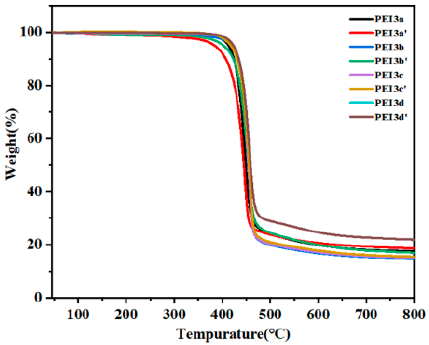
Figure 4. TGA curves of PEI3a–PEI3d ′ .